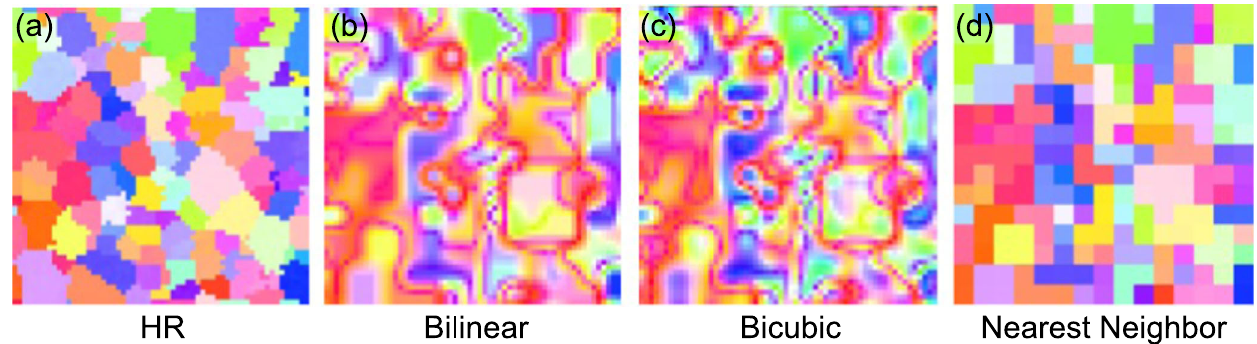
Fig. 4 Comparison of HR ground truth to traditional upscaling. Compared to a high-resolution ground truth EBSD map, b bilinear, c bicubic, and d nearest neighbor upscaling produce inferior results. Bilinear and bicubic results are non-physical, and nearest neighbor results are visually identical to LR input.